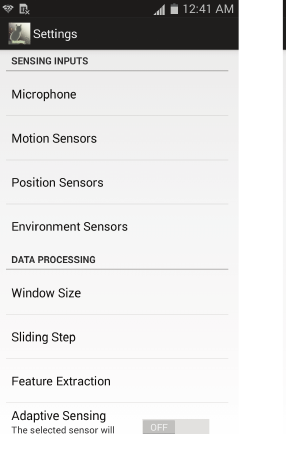
Figure 10. Screenshots of SENSILO settings and